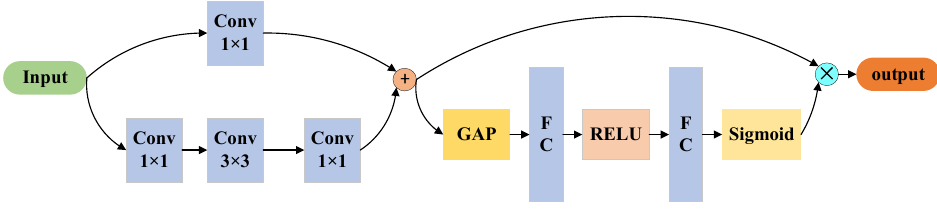
Figure 3. Res-Channel aention block .